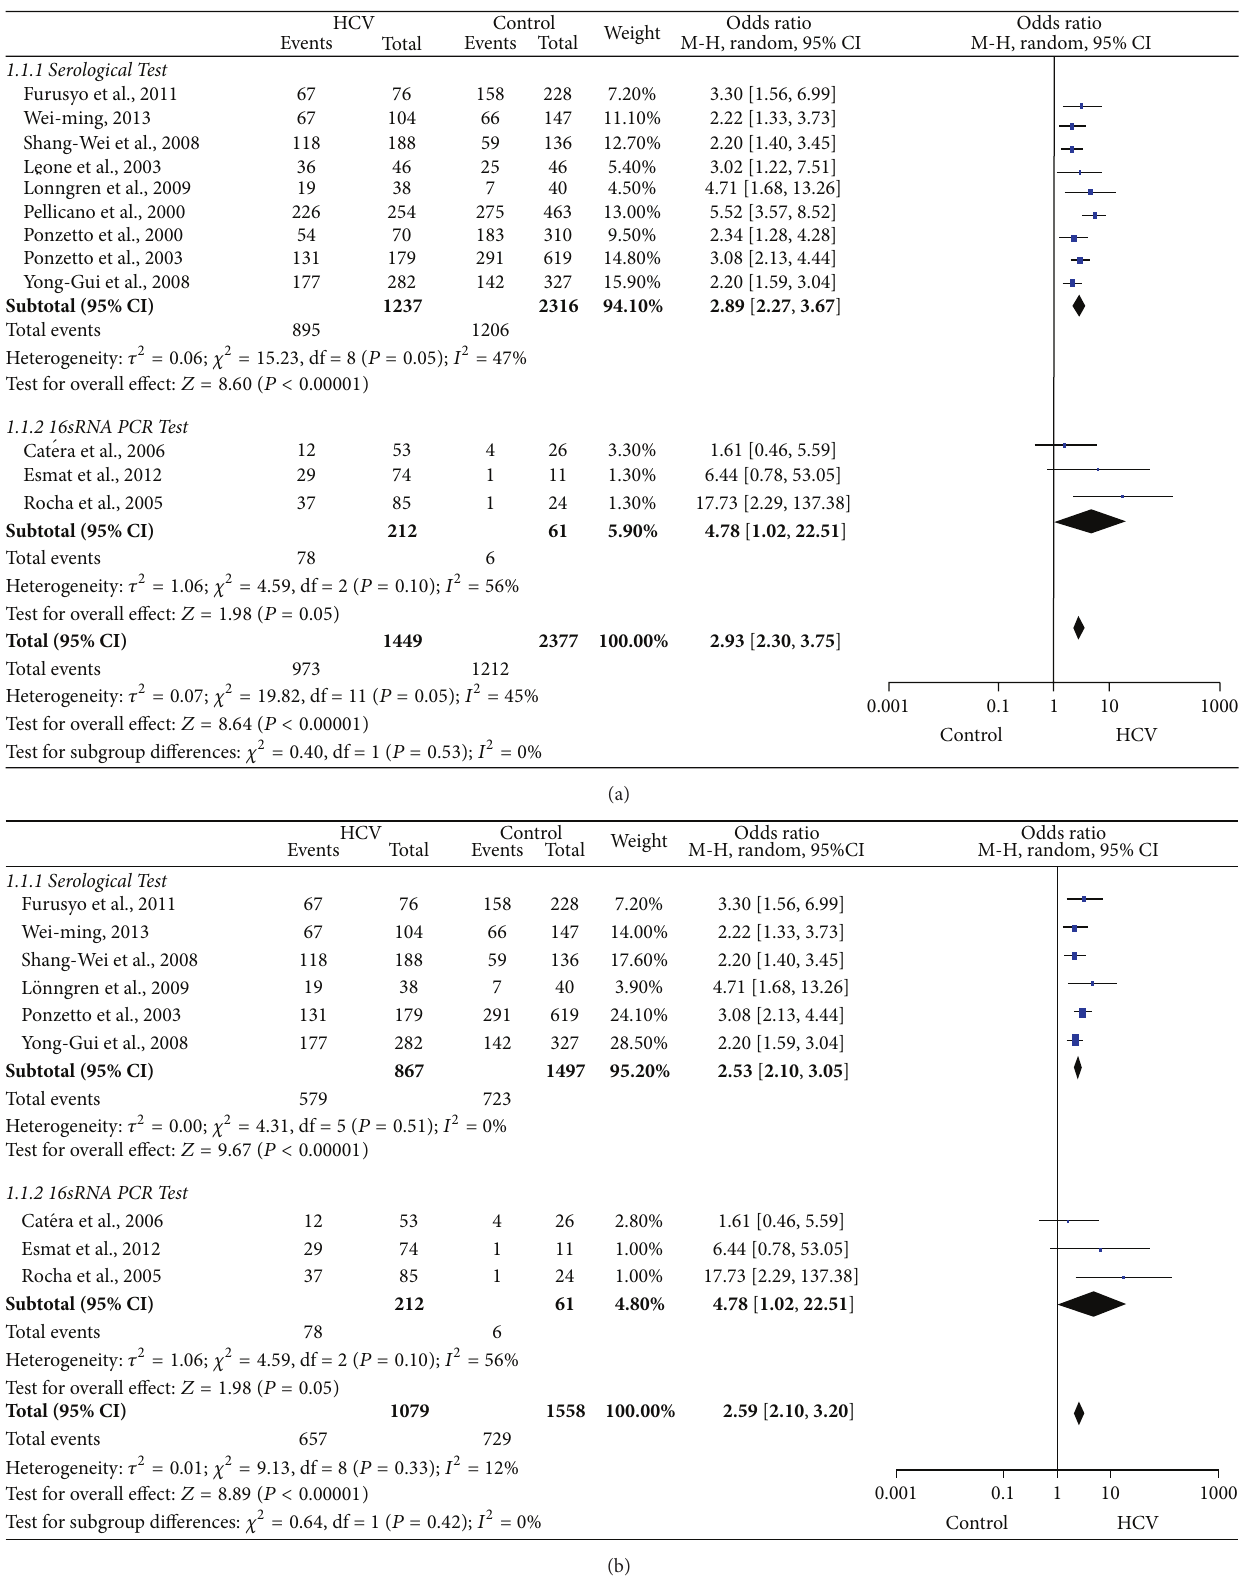
Odds ratio M-H, random, 95%CI M-H, random, 95%